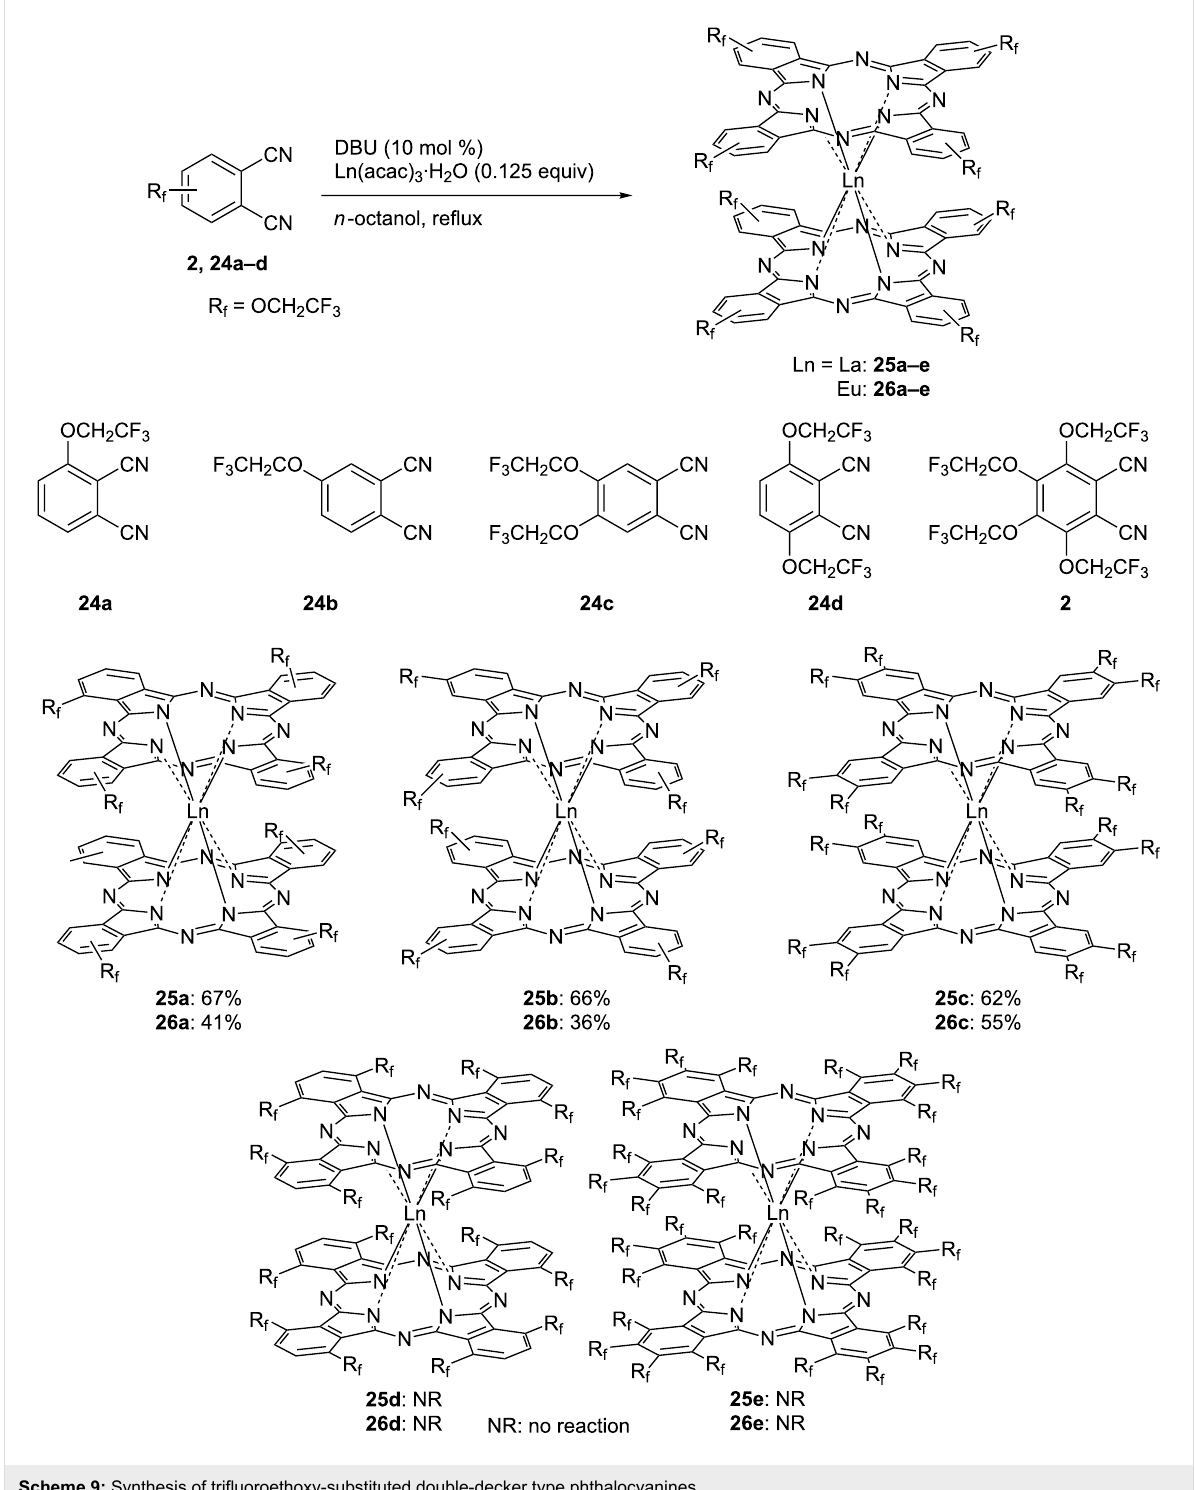
Scheme 9: Synthesis of trifluoroethoxy-substituted double-decker type phthalocyanines.